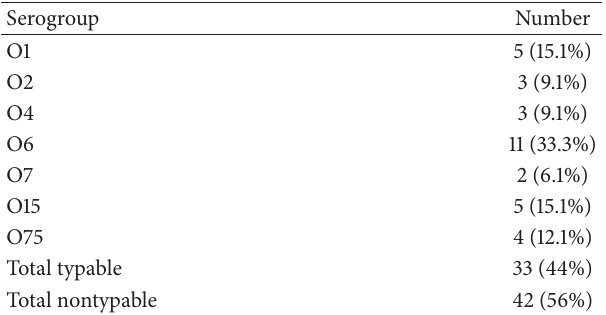
Table 3: Frequency of E. coli serogroups in children with urinary tract